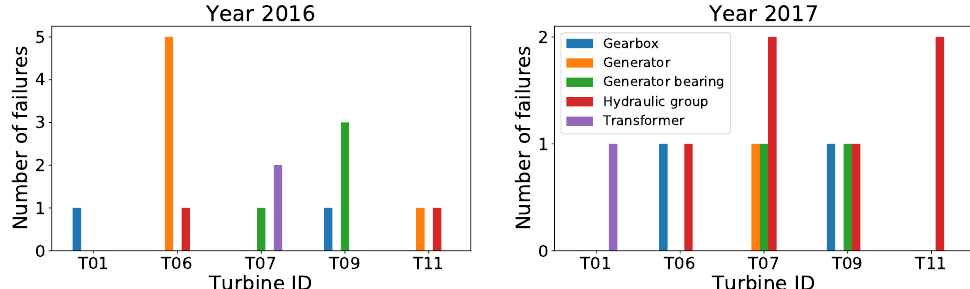
Figure 3. Failure summary in 2016 and